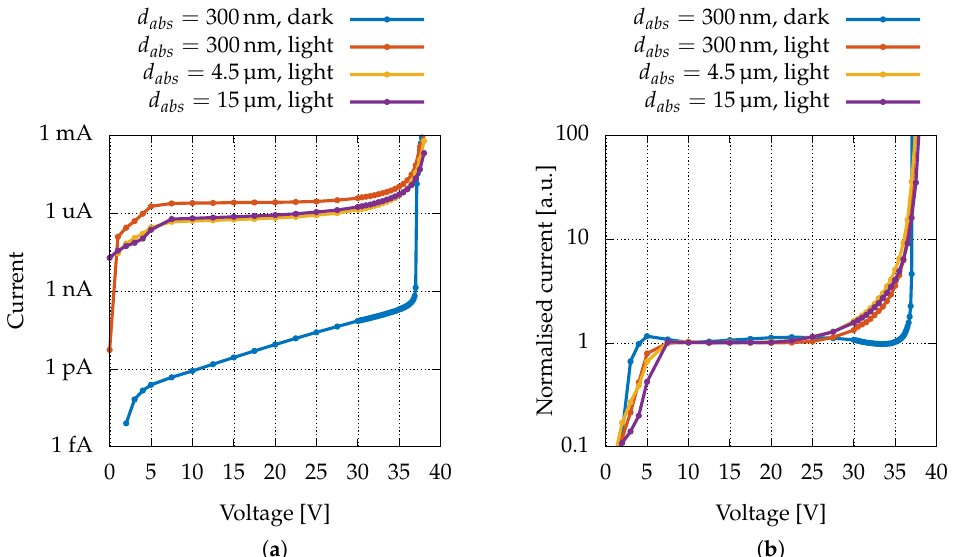
Figure 5. ( a ) Dark I–V characteristics of the device with d abs = 300 nm compared to light I–V measurements ( P laser 50 µ W, λ = 532 nm) of the three types of devices. Dark currents of the other ≈ types of devices present no appreciable differences with the one presented in this graph on this scale and were omitted for clarity. ( b ) Normalised I–V